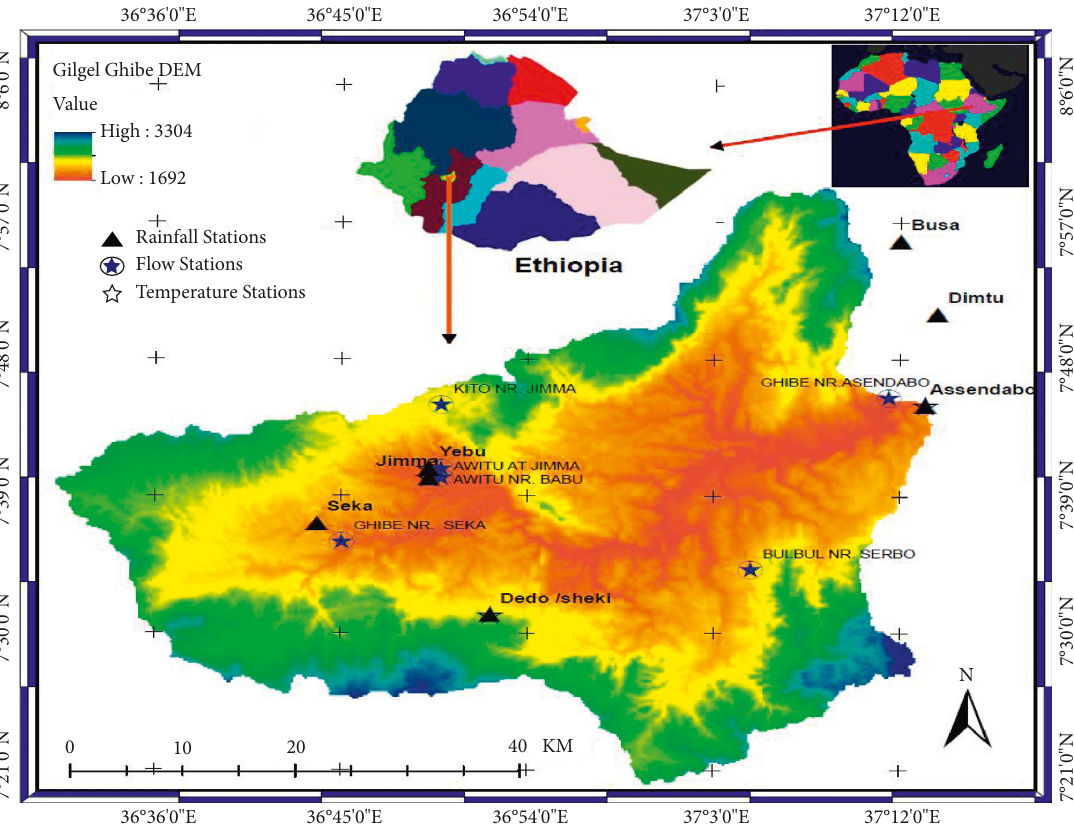
Figure 1: Location map of Gilgel Gibe catchment [3].